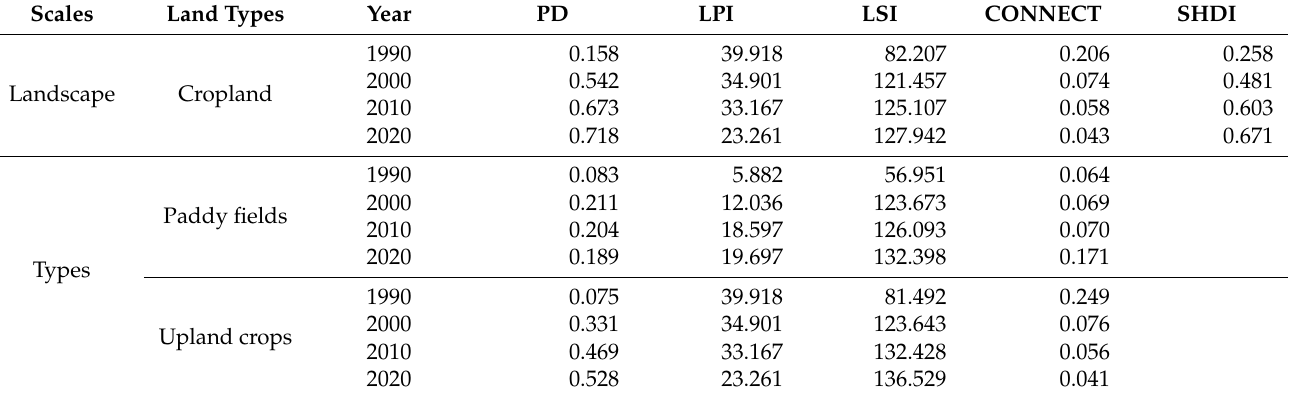
Table 5. Landscape pattern statistics of cropland structure change at landscape and type scales during the period of